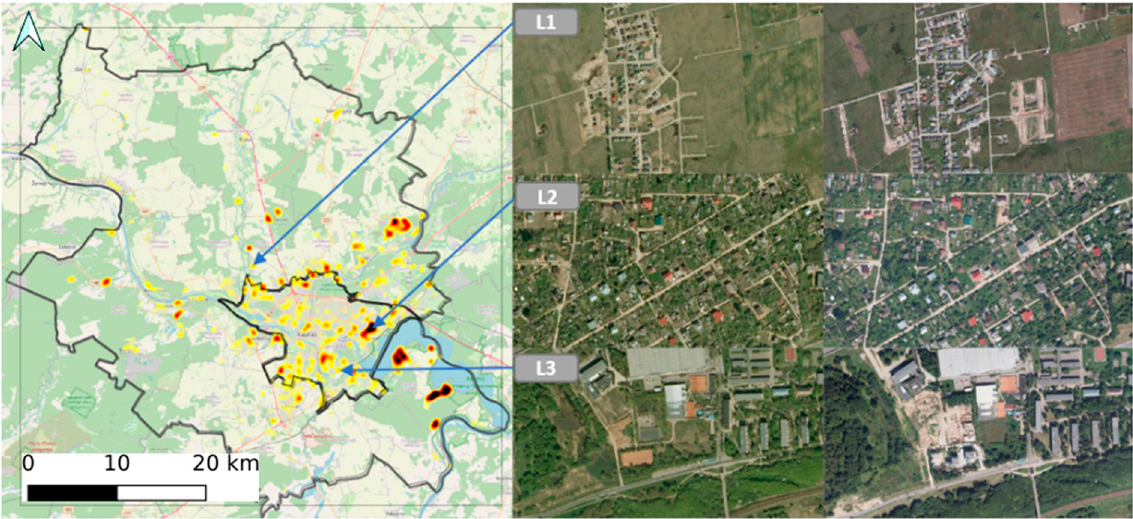
Figure 14. Heat map of difference between total number of buildings in grid cell for periods 2009–2010 and 2012–2013 in Kaunas city and region and examples of images in locations L1, L2, L3.